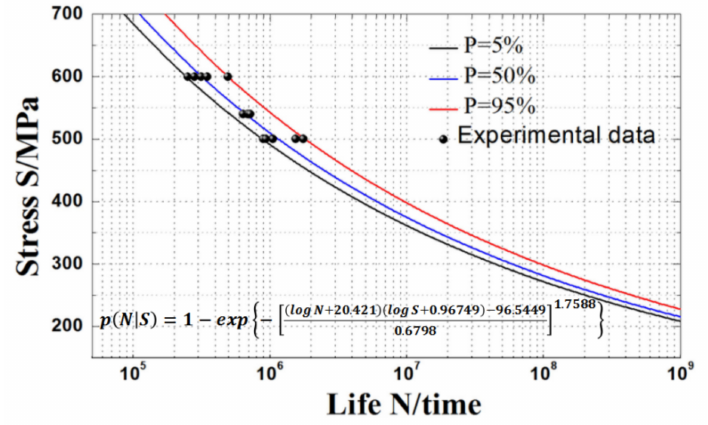
Figure 6. Fatigue S - N curve of HY-type ultra-high strength sucker rod obtained by three-parameter Weibull distribution model under different failure probabilities.